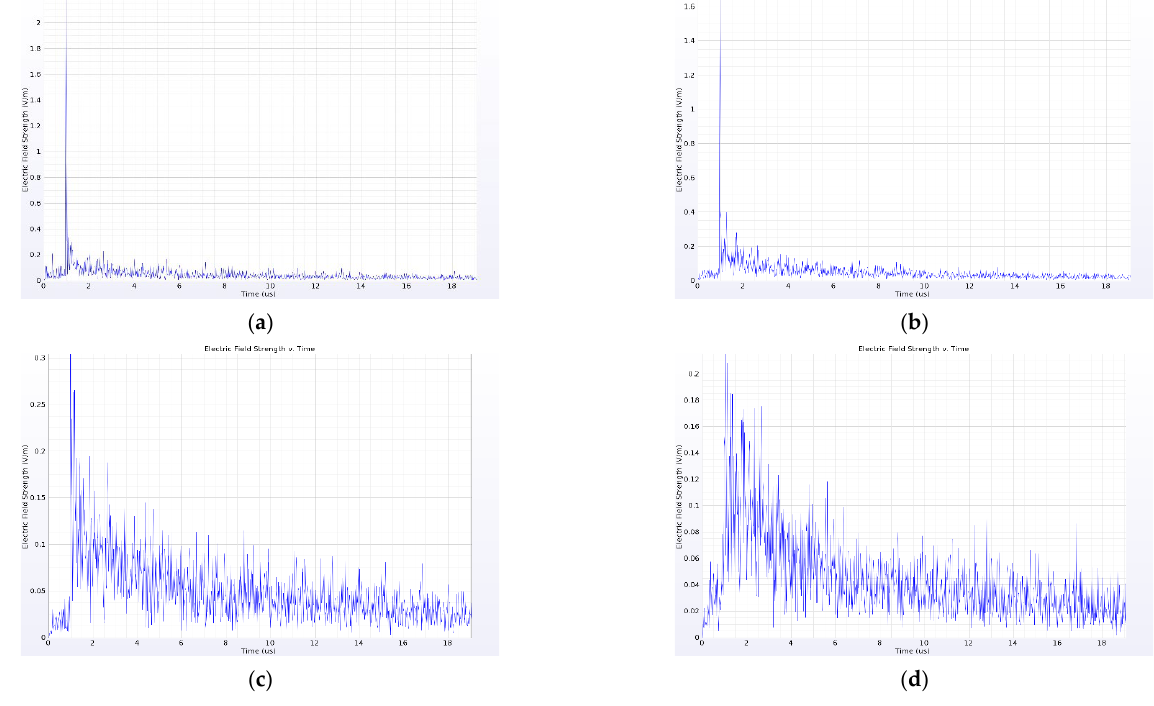
Figure 9. Effect of insulator on near-field propagation characteristics of PD electromagnetic wave signal. ( a ) Electric field strength at point sensor 1; ( b ) Electric field strength at point sensor 2; ( c ) Electric field strength at point sensor 3; ( d ) Electric field strength at point sensor 4.